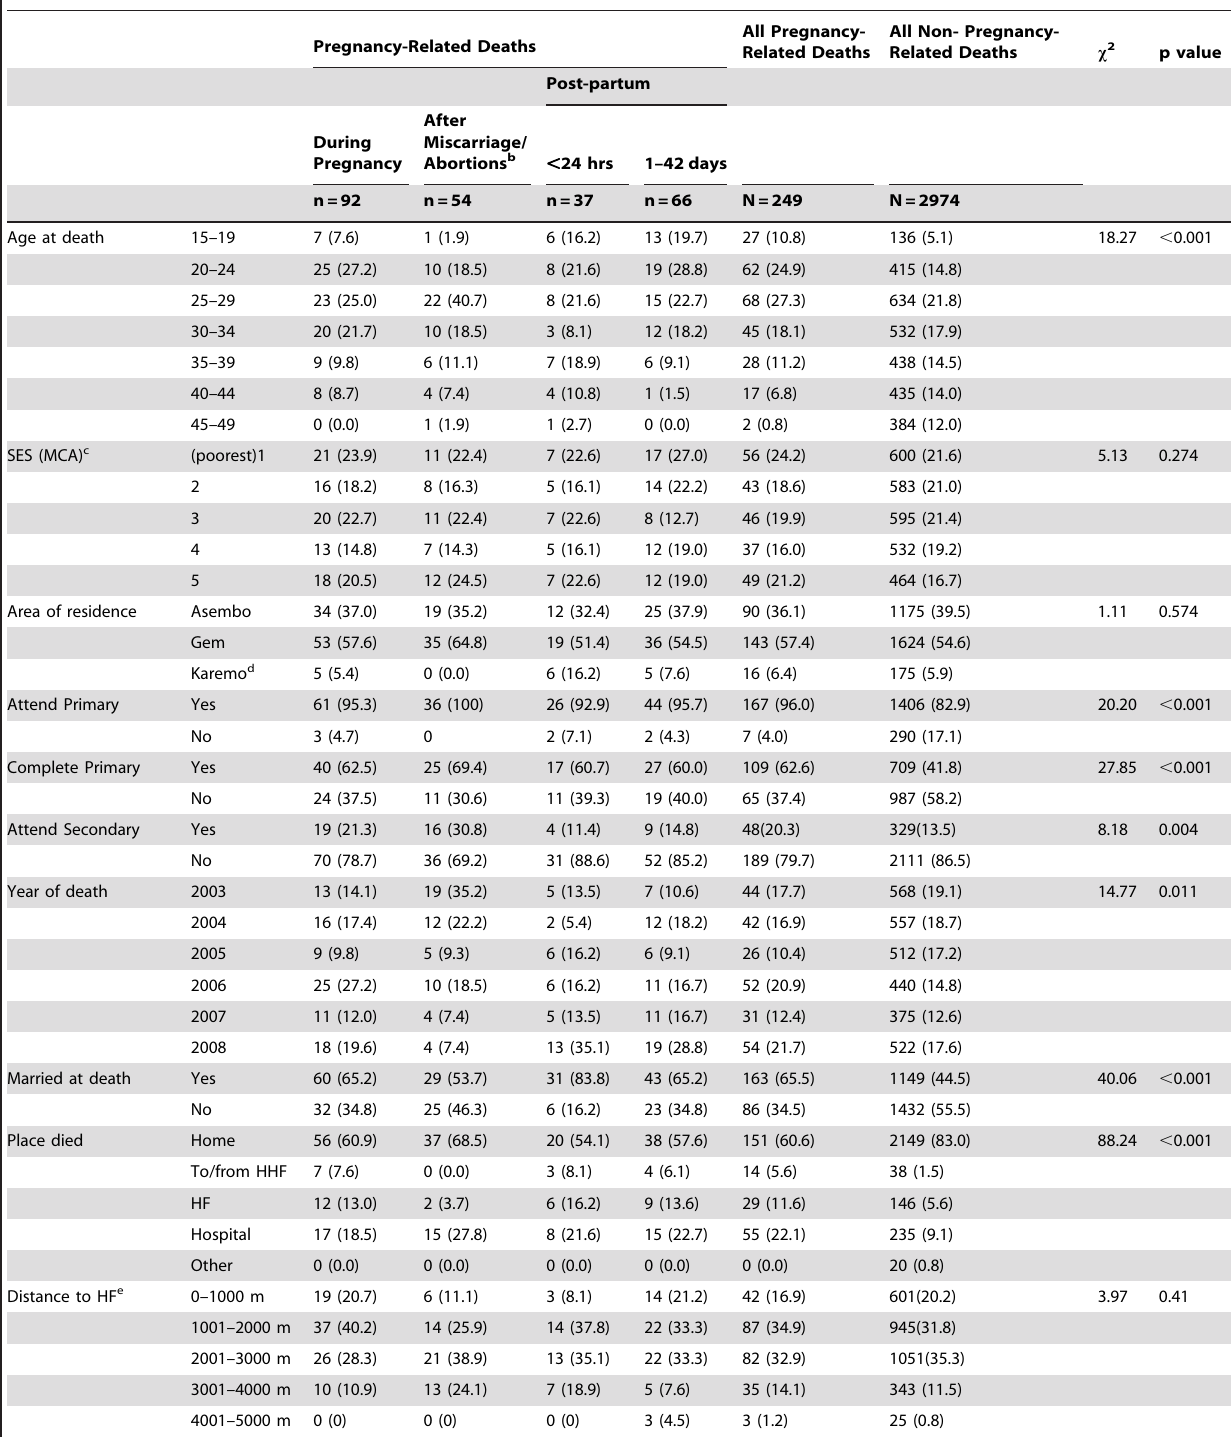
Table 1. Distribution of pregnancy-related and non-pregnancy-related deaths of women 15–49 years by socio-demographic and health-related characteristics.